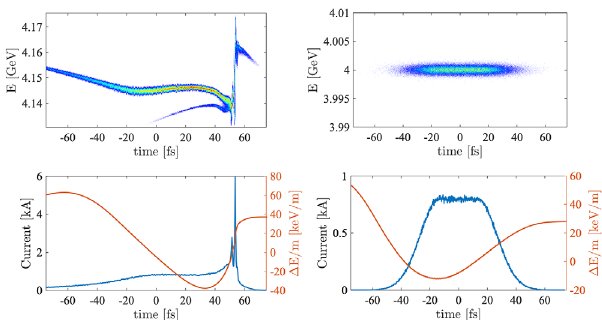
FIG. 2. Longitudinal phase spaces of the electron beams used in LCLS-II FEL simulations (head is to the right). The 100 pC start- to-end e-beam from IMPACT optimizations is on the left, and the 50 pC ideal e-beam is on the right. Also shown: current profiles and time-dependent energy loss per meter in the undulator due to resistive wall wakefields (RWWs).